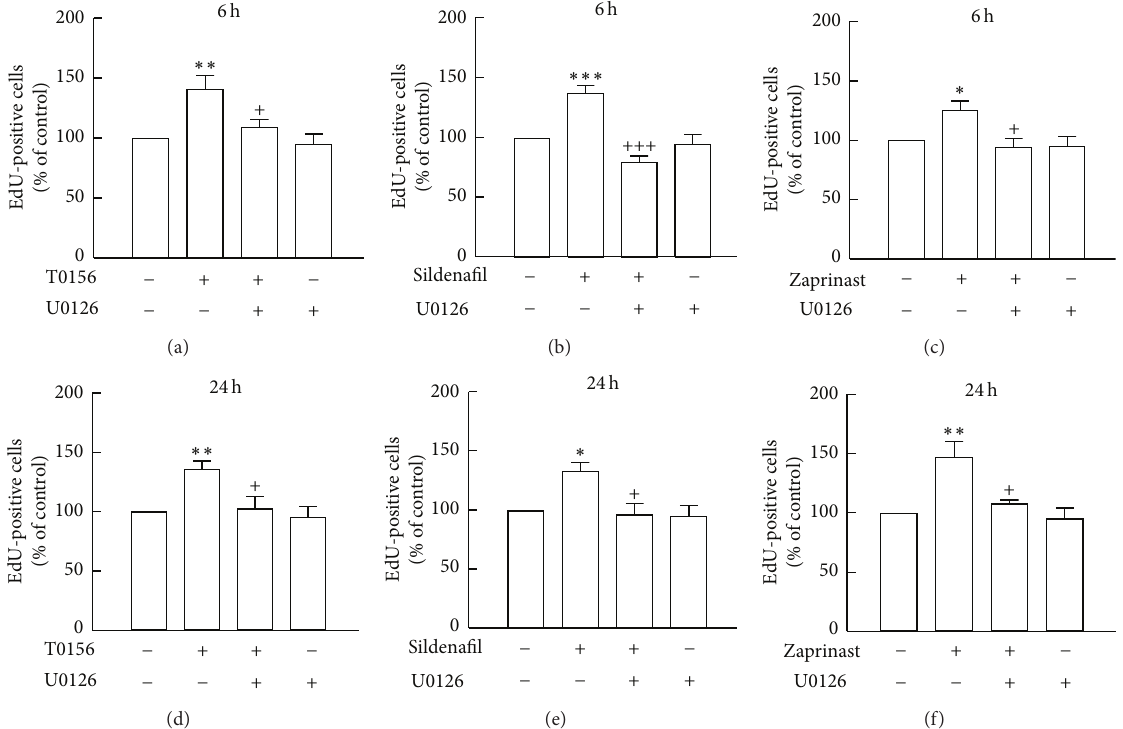
Figure 2: Inhibition of the ERK1/2 pathway prevented proliferation of SVZ cells stimulated by PDE5 inhibitors. Cell proliferation following treatment with 1 𝜇 M U0126 and 1 𝜇 M T0156 (a, d), 1 𝜇 M sildenafil (b, e) or 10 𝜇 M zaprinast (c, f) was assessed by incorporation of EdU and evaluated by flow cytometry following 6 h and 24 h of treatment. Data are expressed as means ± SEM of at least 4 independent experiments. One-way ANOVA (Bonferroni’s post-test), ∗ 𝑃 < 0.05 , ∗∗ 𝑃 < 0.01 , and ∗∗∗ 𝑃 < 0.001 , significantly different from control and + 𝑃 < 0.05 , and +++ 𝑃 < 0.001 , significantly different from the PDE5 inhibitor.